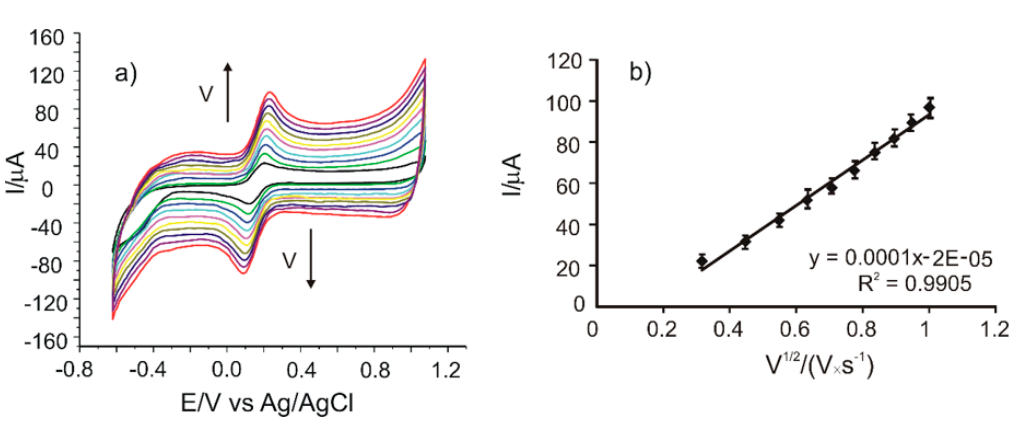
Figure 2. ( a ) Cyclic voltammograms of CNF / C-SPE immersed in 10 − 3 M K 4 [Fe(CN) 6 ] – 0.1 M KCl solution registered with scan rates in the range of 0.1–1.0 V · s − 1 . ( b ) Plot of I pa vs. v 1 / 2